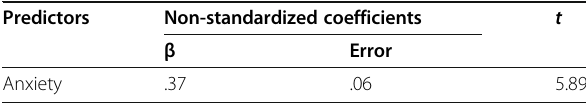
Table 6 Synthesis of the multiple regression model (enter) for